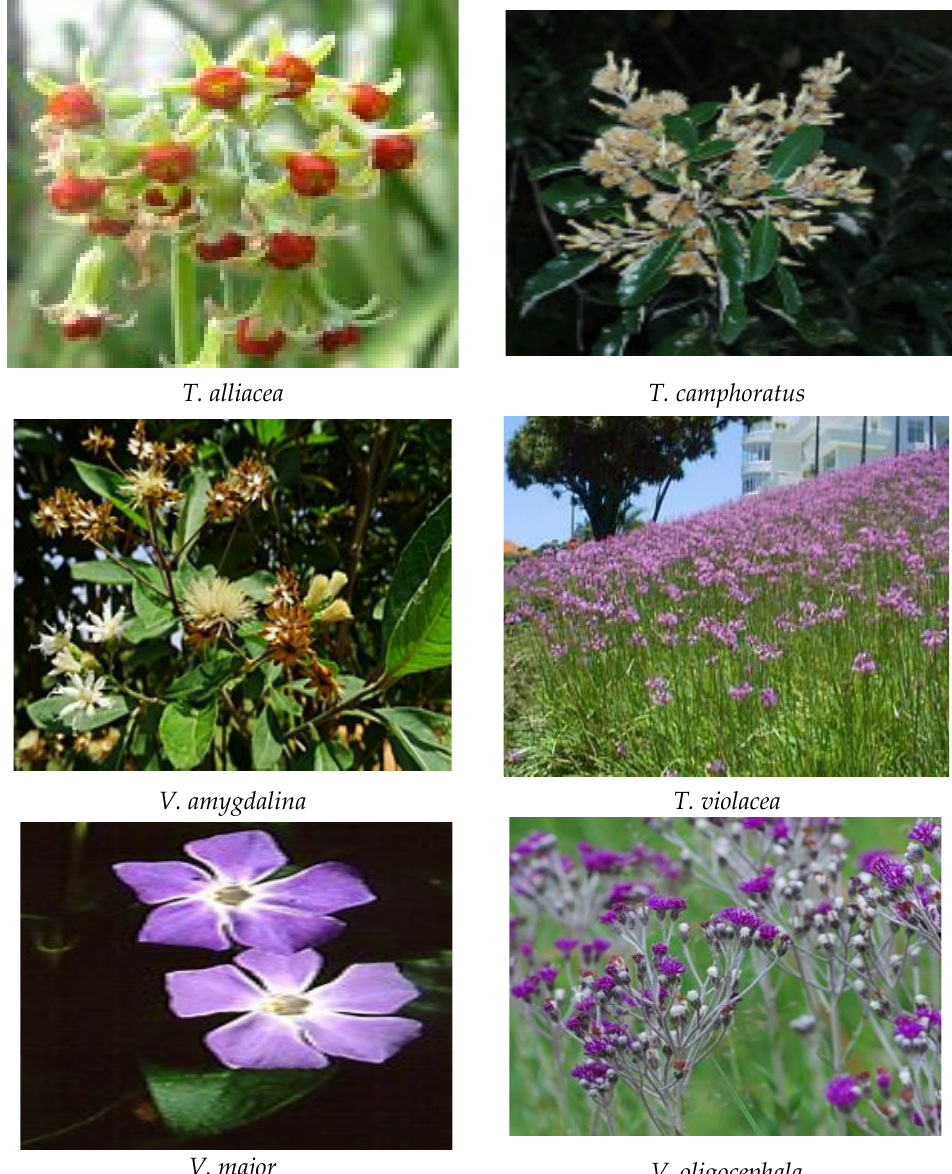
Figure 3. Selected medicinal plants used by the people of Eastern Cape for the treatment of diabe- tes [101–143]. betes